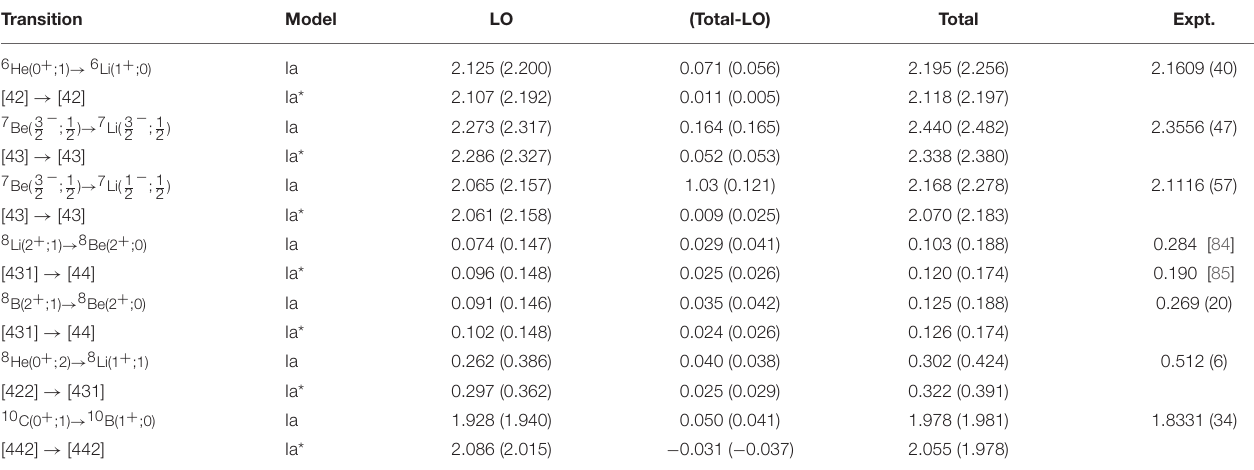
Results corresponding to the one-body current at LO (column labeled “LO”), and to the sum of all the corrections beyond LO (column labeled “Total-LO”) are given, along with the cumulativecontributions(columnlabeled“Total”)tobecomparedwiththeexperimentaldata[81–85]reportedinthelastrow.StatisticalerrorsassociatedwiththeMonteCarlointegrations are not shown, but are below 1%. Transitions for the A = 8 systems are affected by an additional systematic error of ∼ % , see text for explanation.